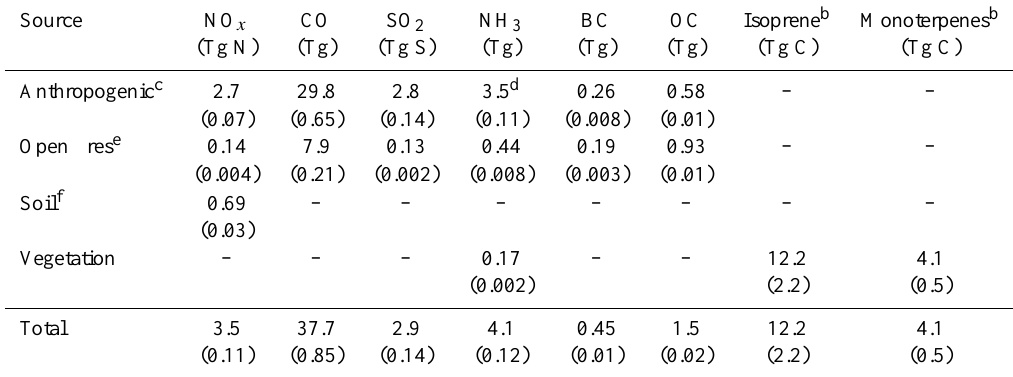
Table 1. Contiguous US (CONUS) emissions for 2013 a .